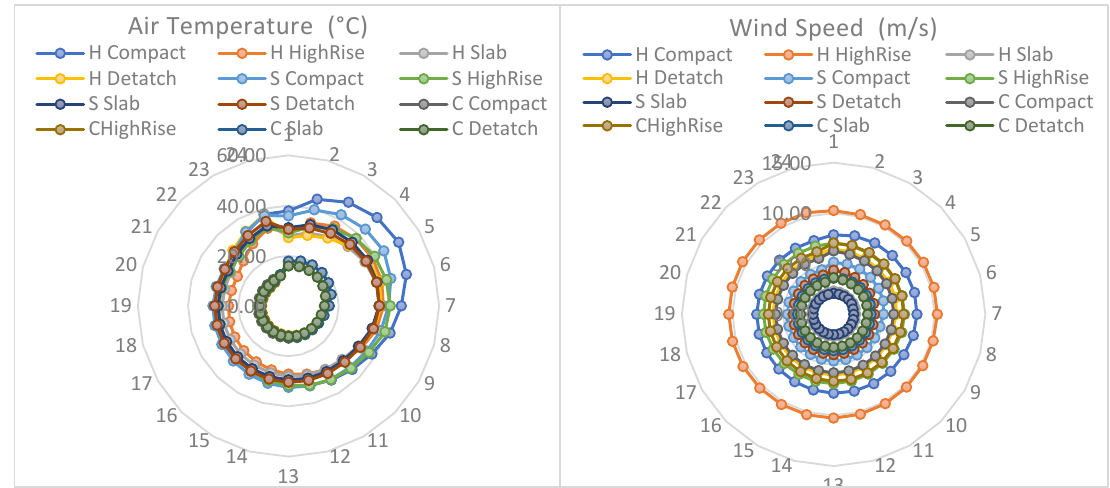
Fig. 10: Wind Speed on the hottest, coldest and sultriest day of the year in the form of four morphotypes in the current situation